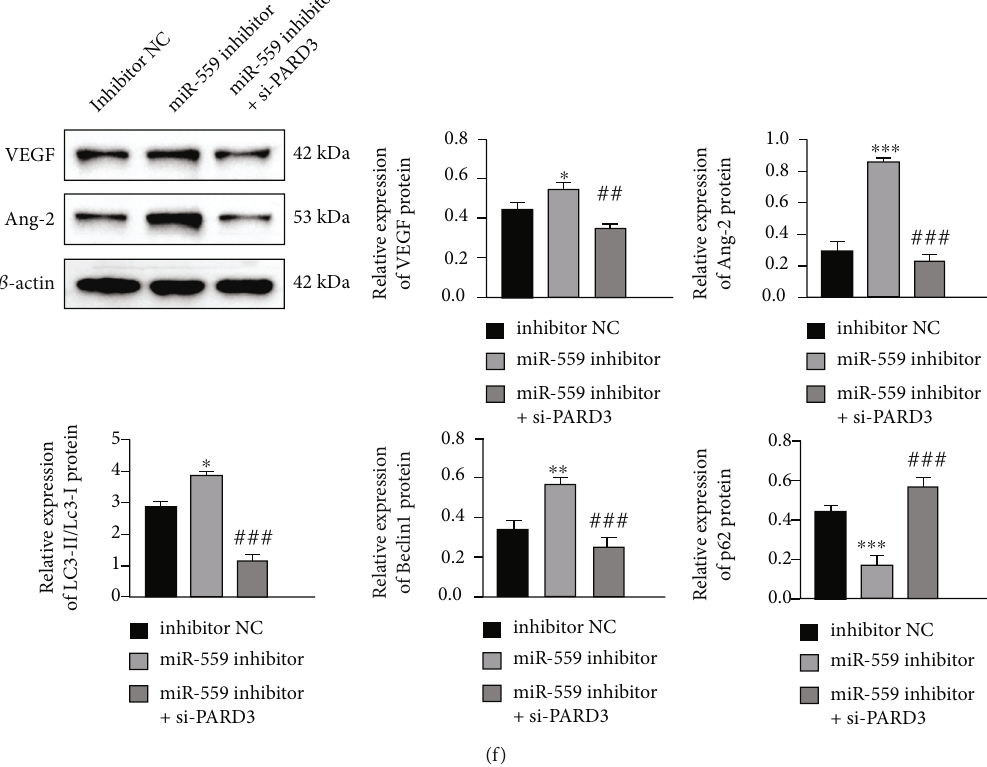
Figure 5: PARD3 silencing reversed the e ff ects of the miR-559 inhibitor on Huh-7 cells. Huh-7 cells were cotransfected with the miR-559 inhibitor and si-PARD3 for 24h. The mRNA (a) and protein (b) levels of PARD3 in Huh-7 cells. (c) Using the CCK8 assay to detect cell viability. (d) The expression levels of LC3-II/I, Beclin1, and p62 were measured by the western blot assay. (e) HUVEC tube formation assay was proposed using conditioned medium in vitro . (f) The protein levels of VEGF and Ang-2 were detected by western blotting in Huh-7 cells. The values were obtained from three independent experiments and shown as mean ± SD . ∗ p < 0 : 05 , ∗∗ p < 0 : 01 , and ∗∗∗ p < 0 : 001 , compared with inhibitor NC; ## p < 0 : 001 and ### p < 0 : 001 , compared with the miR-559